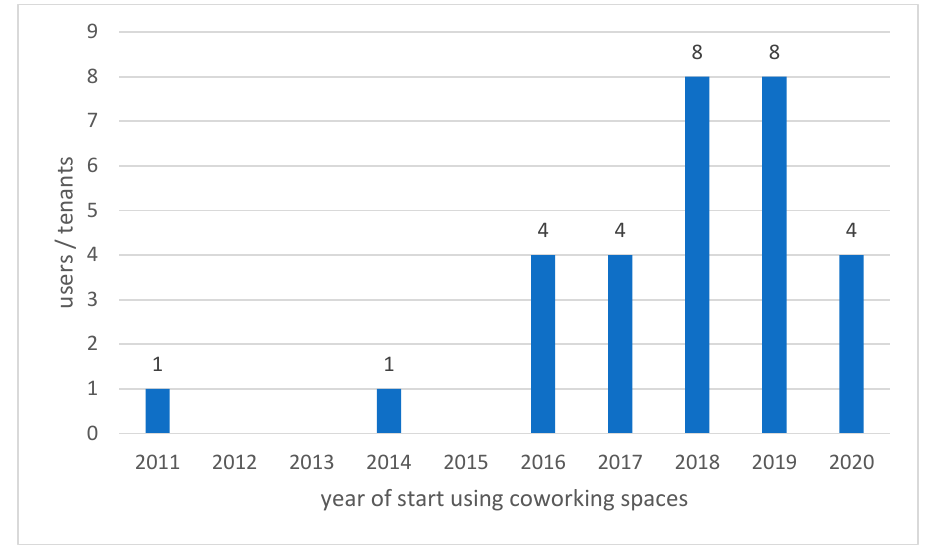
Figure 1. Start year of the work in coworking spaces. Less than one third (28 %) of the respondents indicate that they are using coworking spaces each day. The same amount of people state that they are using the coworking space 3 days a week. Nearly one third (31 %) of people are using coworking spaces 1 or 2 times a week. And 14 % are using a coworking space 1 or times in a month (n=29) (Figure 2).